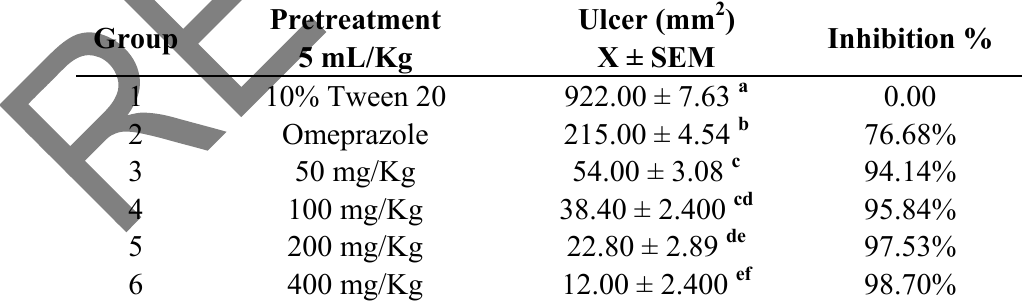
Table 2. Liver function test of rats in acute toxicity study of BClHC compound. Animal Total Albumin Groups protein (g/L) Normal 70.34 ± control